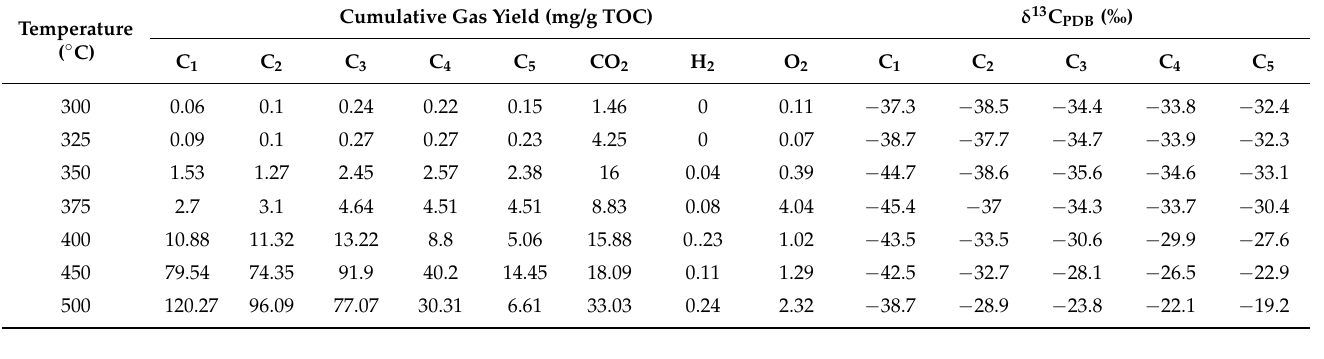
Table 4. Cumulative yields of gases and isotopic composition of alkane gases generated during the pyrolysis experiment in a semi–closed hydrous system.